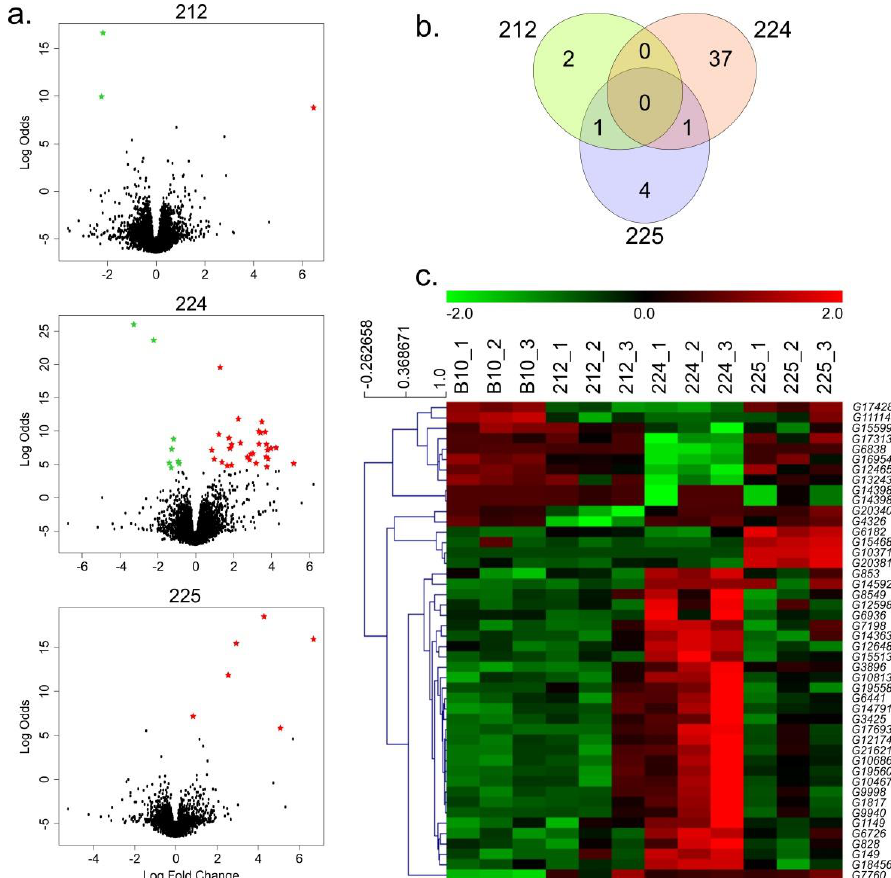
Figure 2. ( a ) Volcano plots of di ff erentially expressed genes from three cucumber transgenic lines (212, 224, and 225) versus the wild-type B10 line. Green and red asterisks indicate significant results; black dots indicate non-significant results ( b ) Venn diagrams of di ff erentially expressed genes that overlap between three cucumber transgenic lines (212, 224, and 225) versus the wild-type B10 line. ( c ) Heat map of di ff erentially expressed genes in the fruits of the B10 control and transgenic 212, 224, and 225 lines. DEG expression levels are indicated at the top of the heat map; green indicates down-regulated and red indicates up-regulated genes.